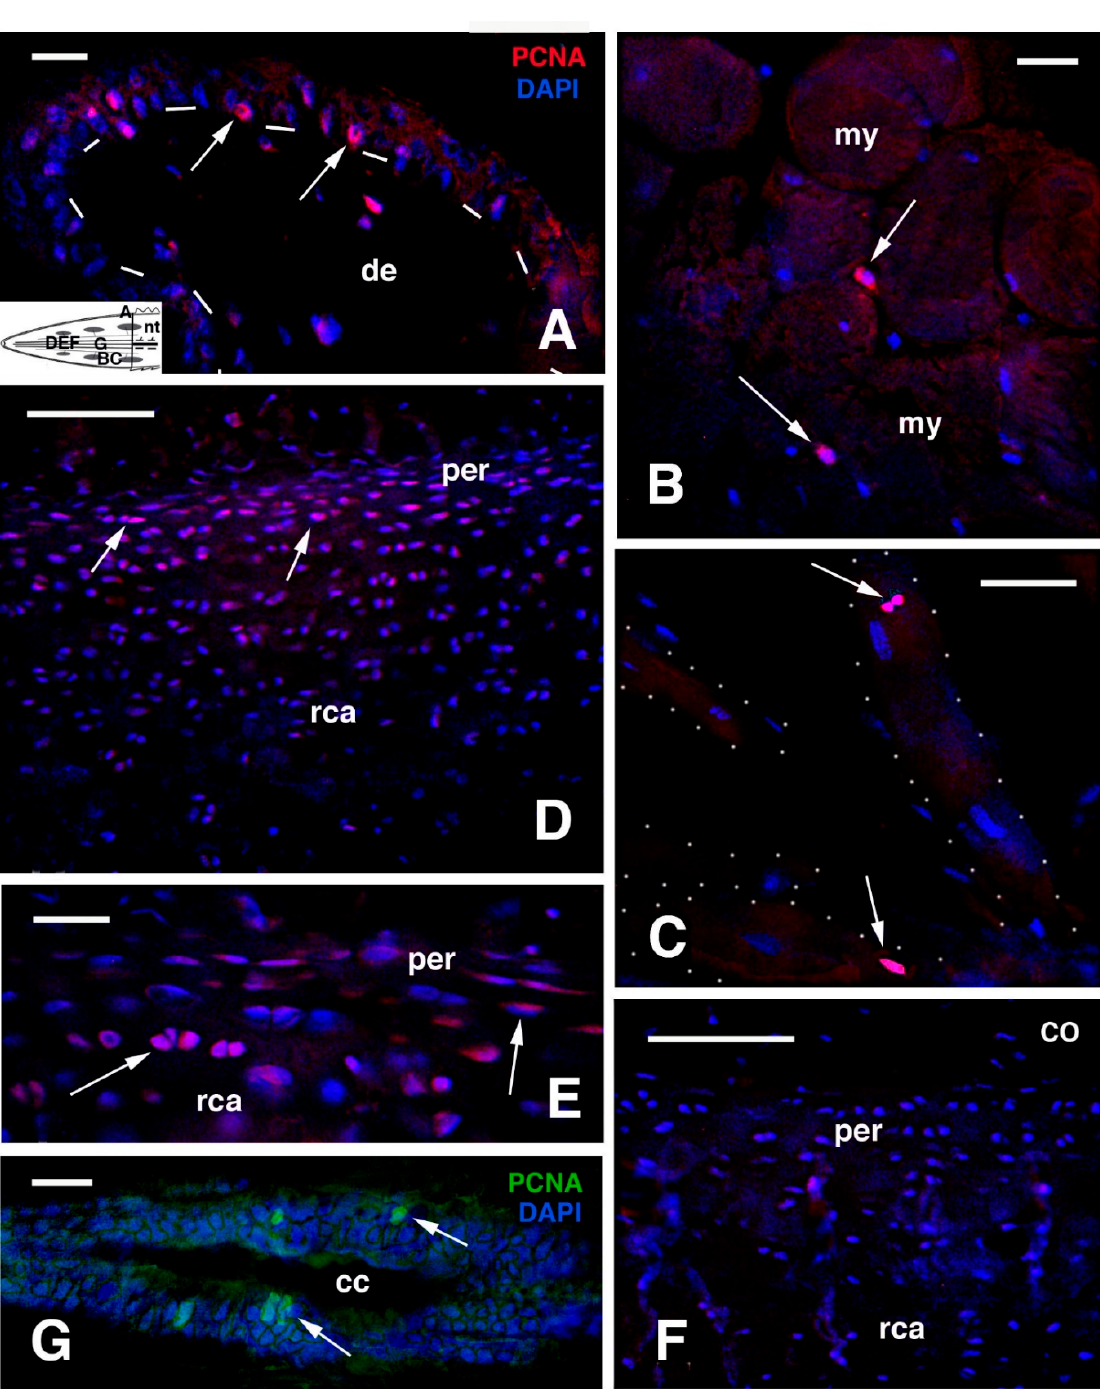
Figure 8. Immunofluorescence using the PCNA antibody. ( A ), neogenic scale located near the tail stump with sparse labelled cells (arrows). Bar, 10 µ m. The schematic inset shows the position of the following images. ( B ), Cross-sectioned proximal muscles. Arrows show two labelled cells. Bar, 10 µ m. ( C ), obliquely-sectioned muscle fibres (outlined by dots) with labelled nuclei (arrows). Bar, 10 µ m. ( D ), external part of the cartilaginous cylinder with labelled flat chondroblasts (arrows) especially abundant in the perichondrium. Bar, 50 µ m. ( E ), detail of labelled cells (arrows) in the perichondrium. Bar, 20 µ m. ( F ), immunonegative control sections (CO) of cartilaginous cylinder. Bar, 50 µ m. ( G ), detail on the ependyma of medio-proximal region showing few labelled nuclei (arrows) Bar, 10 µ m. Legends : cc, central canal; de, dermis; my,